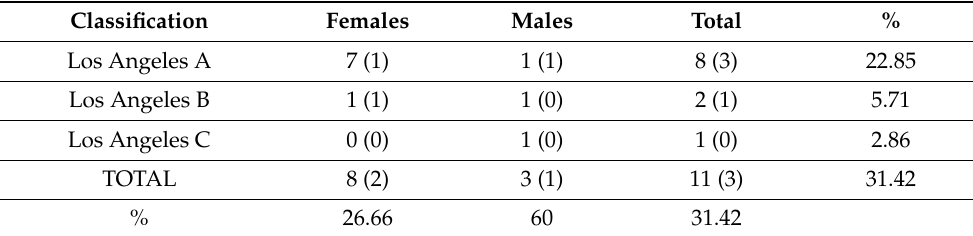
Table 7. Erosive esophagitis ( EE-Esophagitis Erosiva ) in post-operative assessment (in brackets the occurrence of EE in pre-operative assessment).